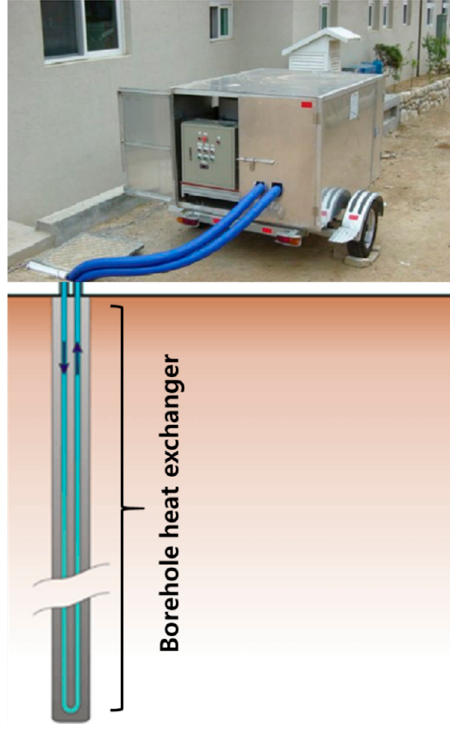
Figure 2. Thermal response test apparatus [51].